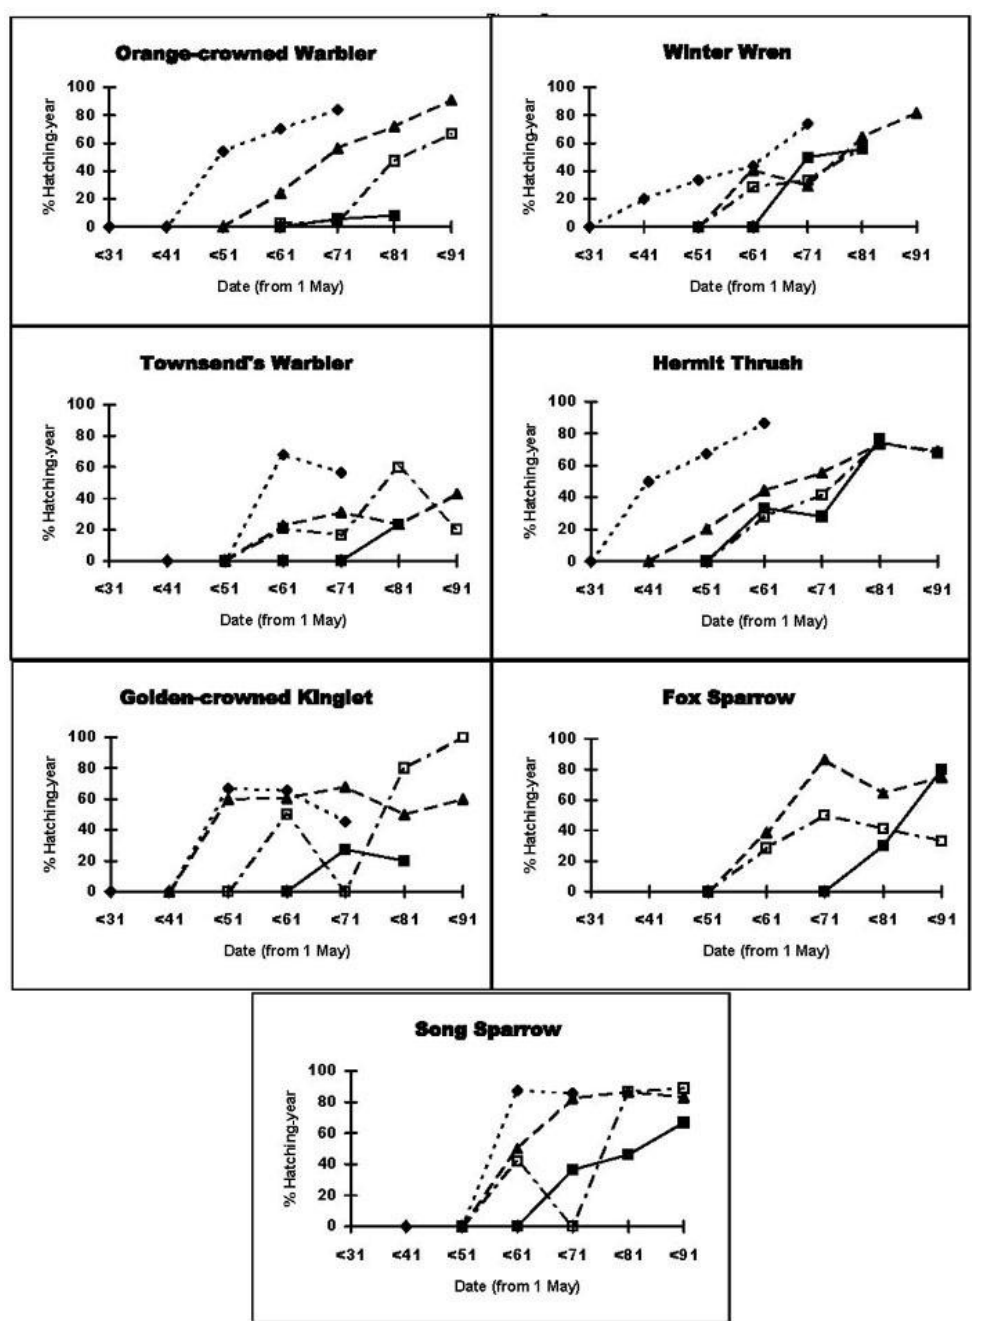
Fig. 4 . Trends in the proportions of hatching-year birds captured by 10-d periods. Only species with n > 14 are shown. The year 1998 is represented by diamonds; 1999, by solid squares; 2000, by triangles; and 2001, by open